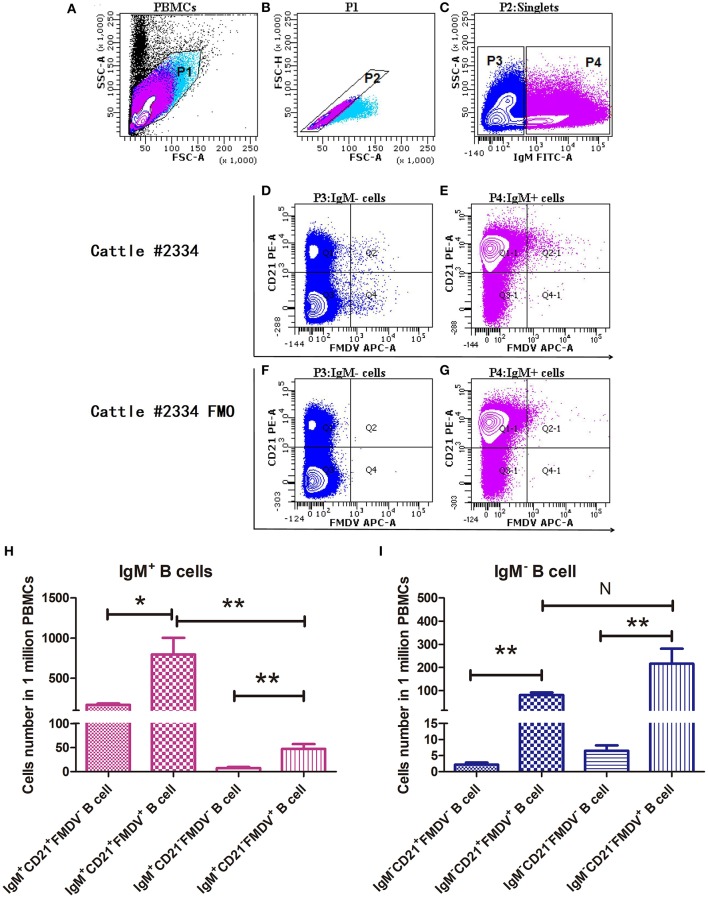
Confirmation of the phenotype and proportion of FMDV-specific plasmablasts in the peripheral blood by flow cytometry. Cattle PBMCs (A) were analyzed by three-color flow cytometry and gate 1 (B) was selected to exclude cells debris with lower values of SSC-A and FSC-A, and further analyzed to gate singlets (C) based on diagonal streak of the FSC-A and FSC-H plot. The IgM− B cells were gated to check the distribution of CD21 and FMDV-specific cells, in the presence (D) or absence (F) of FMDV antigen. Similarly, IgM+ B cells were gated to check the distribution of CD21 and FMDV-specific cells, in the presence (E) or absence (G) of FMDV antigen. One million PBMCs were collected per sample. The distribution and phenotype of FMDV-specific plasmablasts in the IgM+ B cells (H) and the IgM− B cell (I) population were analyzed. The differences between two groups were marked with asterisks in t-test; wherein the alpha values were labeled as NS (P > 0.05), *P < 0.05 and **P < 0.01.